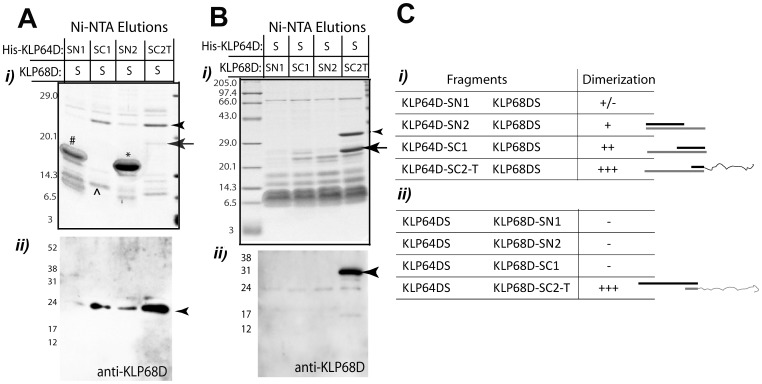
Combinatorial expression and pull-down analysis of full stalk and stalk fragments of kinesin-II motor subunits.A) 6xHis tagged KLP64D stalk fragments were coexpressed in E. coli, along with the KLP68DS, and purified by Ni-NTA chromatography, and separated by SDS-PAGE. i) Coomassie staining of SDS-PAGE gel of the Ni-NTA eluates. ii) Anti-KLP68D staining of the western blot of a similar gel indicates the presence of the KLP68DS bands (arrowhead) in different lanes. His-KLP64D-SN1 (#), -SC1 (∧) and –SN2 (*) bands; a relatively weak His-KLP64D-SC2-T band (arrow); and KLP68DS (arrowhead) are labeled. B) A similar experiment was performed with extracts of the E. coli coexpressing the His-KLP64DS and different KLP68D stalk fragments as indicated in the top panel. The arrow indicates His-KLP64DS band in (i) and the arrowheads indicates the KLP68D-SC2-T bands in both (i) and (ii). Since His-KLP64DS is only stable in a heterodimer with KLP68DS, the band was only visible in the last lane where it copurified KLP68D-SC2-T. C) The pull down results presented in panels A and B are summarized in tables (i) and (ii) respectively. Heterodimer formation is represented by ‘+’ and ‘–‘ denotes absence of heterodimer formation. Cartoon next to the table represents the stalk fragments that form heterodimer.